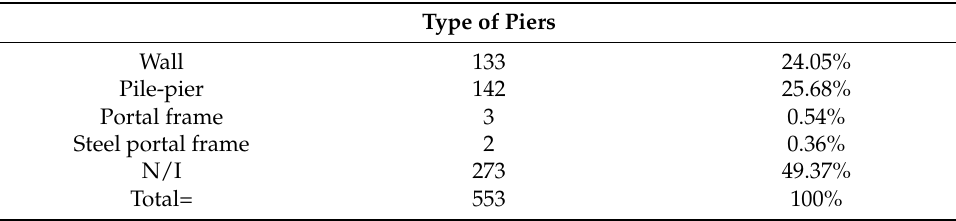
Table 2. Type of piers in Chilean